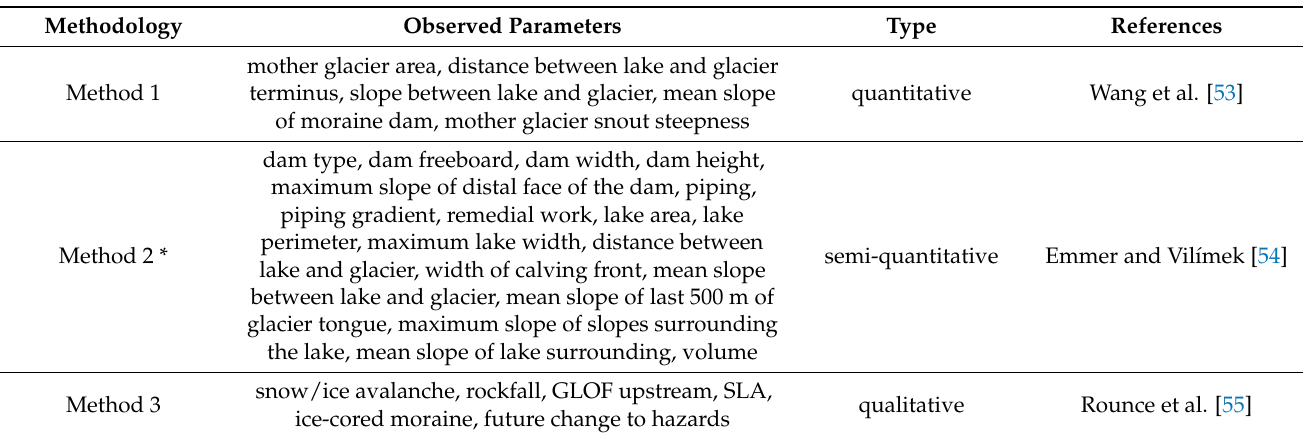
Table 3. Three methodologies used for GLOF hazard assessment in the present